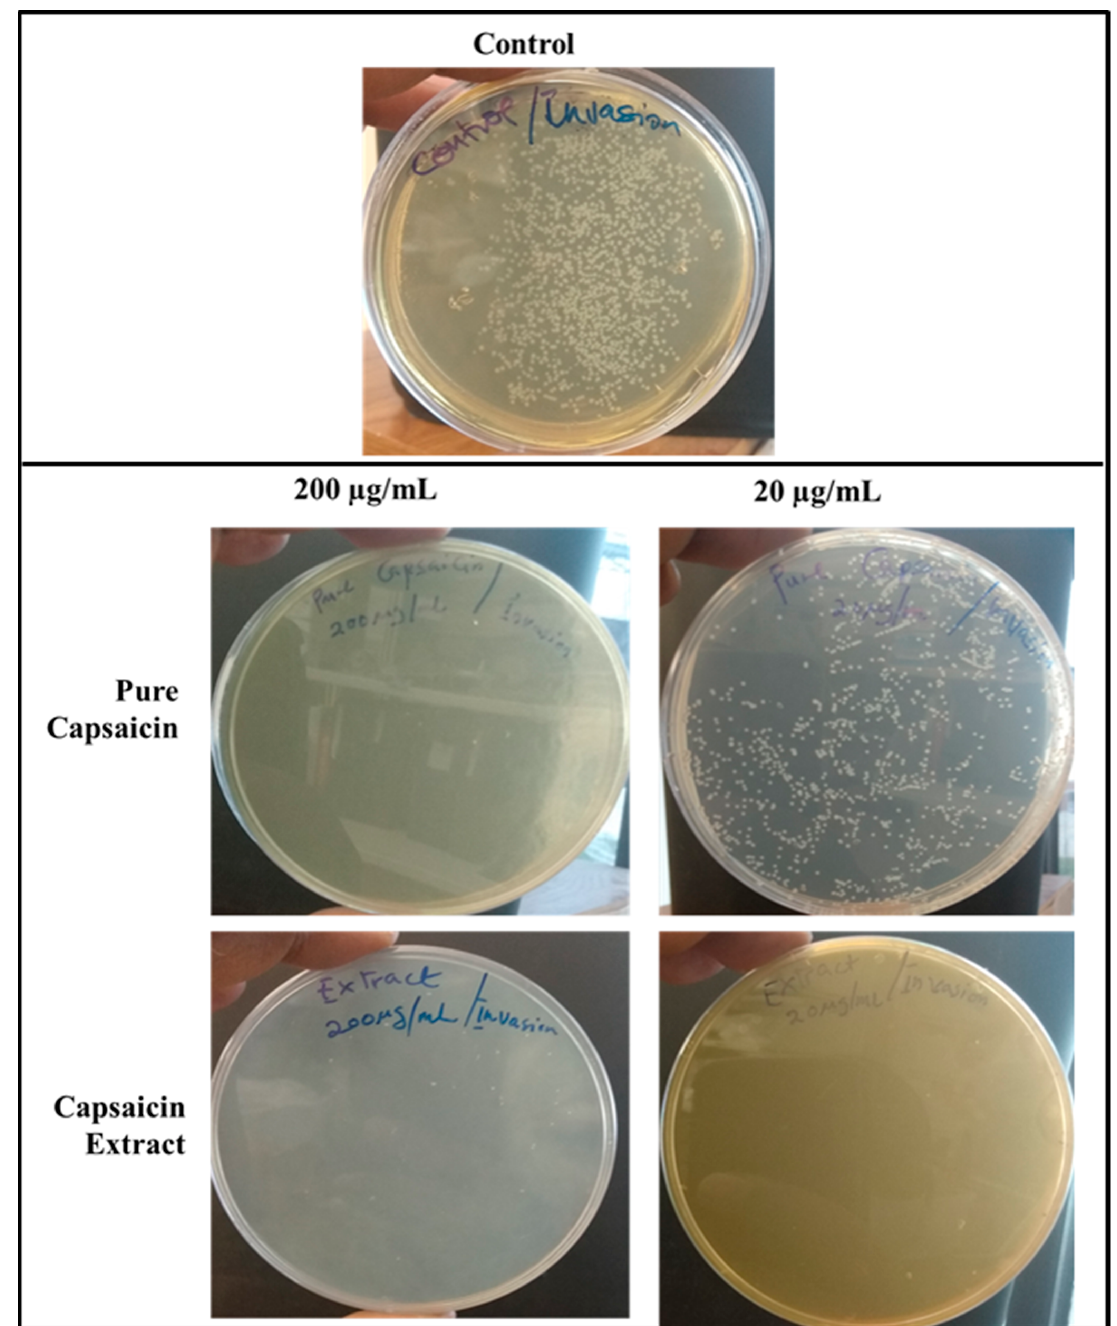
Figure 9. Images of Agar plates depicting the CFUs of S. typhimurium in bacteria invasion assay. Monolayer Vero cells grown in media supplemented with capsaicin at varying concentrations were infected with S. typhimurium and incubated for 2 h to allow for bacterial cell invasion of Vero cells. Then the infected monolayer Vero cells were washed thrice with 1X PBS to remove bacterial cells in suspension and followed with antibiotic treatment for 2 h at 37 °C in 5% CO 2 to kill bacterial cells that adhered to Vero cells but did not internalize. Then antibiotics were washed off and Vero cells lysed with chilled distill water and plated on Agar plates overnight. The treated samples received capsaicin extract at 200 or 20 µg/mL, respectively, whereas the control received 1X PBS.